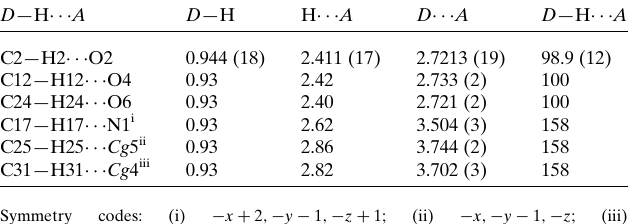
Table 1 Hydrogen-bond geometry (A˚ , (cid:2) ). Cg 4 and Cg 5 are the centroids of the C23–C28 and C30–C35 rings, respectively.